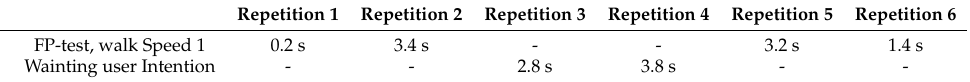
Table 5. Differences in seconds between FP-test task start and false positive activation and between waiting user intention task start and activation of speed command 2 for the FP and TP cases.